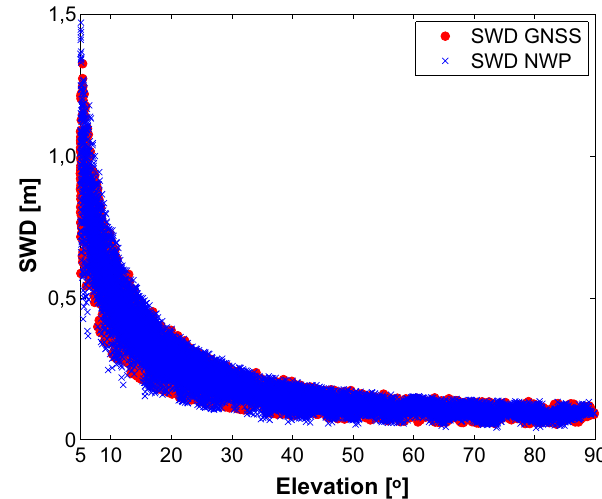
Fig. 12. The SWDs stemming from raytracing through the NWP model (blue), overlayed on SWDs from GNSS processing (red). Each point represents one SWD in relation to the elevation angle, the number of points equals the amount of SWD observations per day in AGS-EUPOS